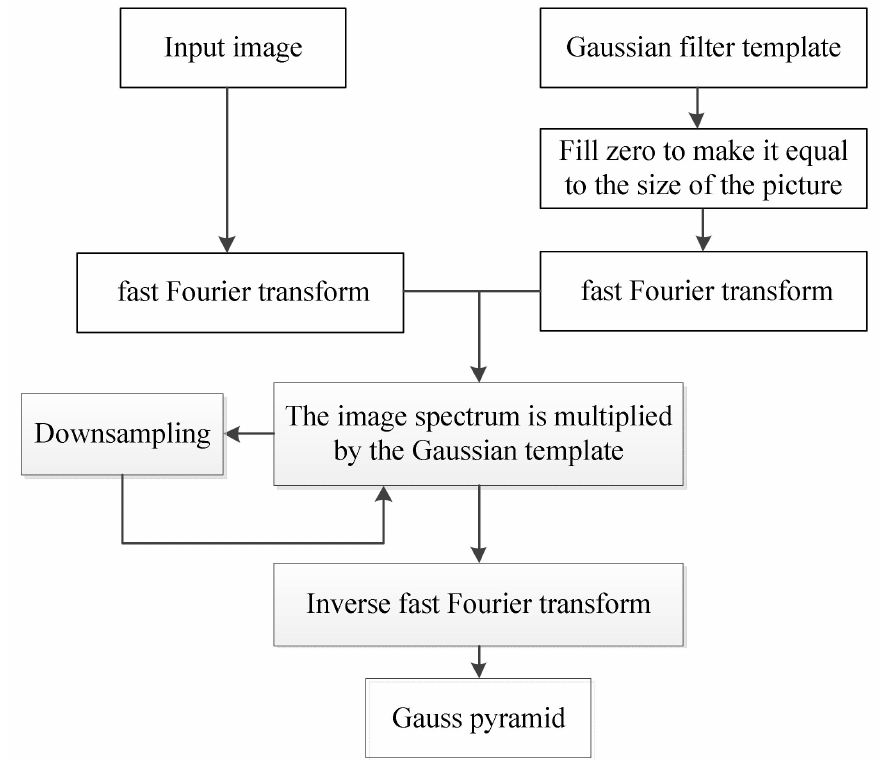
Figure 2. The construction process of the improved Gauss